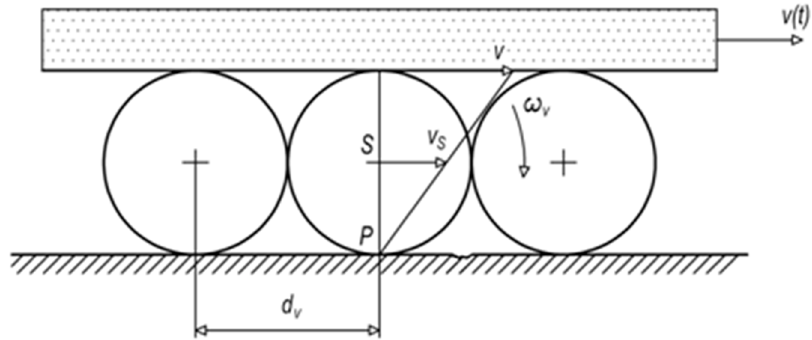
Figure 13. The kinematic scheme—the damage of the guiding profile.